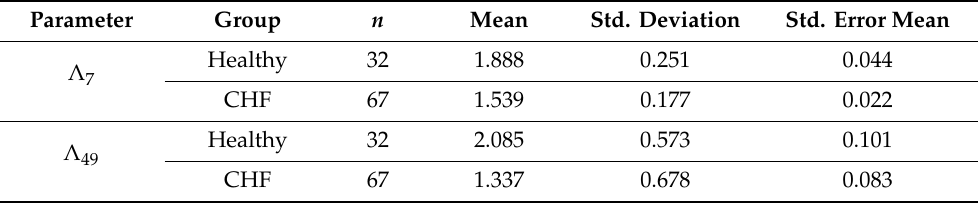
Table 4. Group statistics for the H subjects and CHF patients (PPG method).